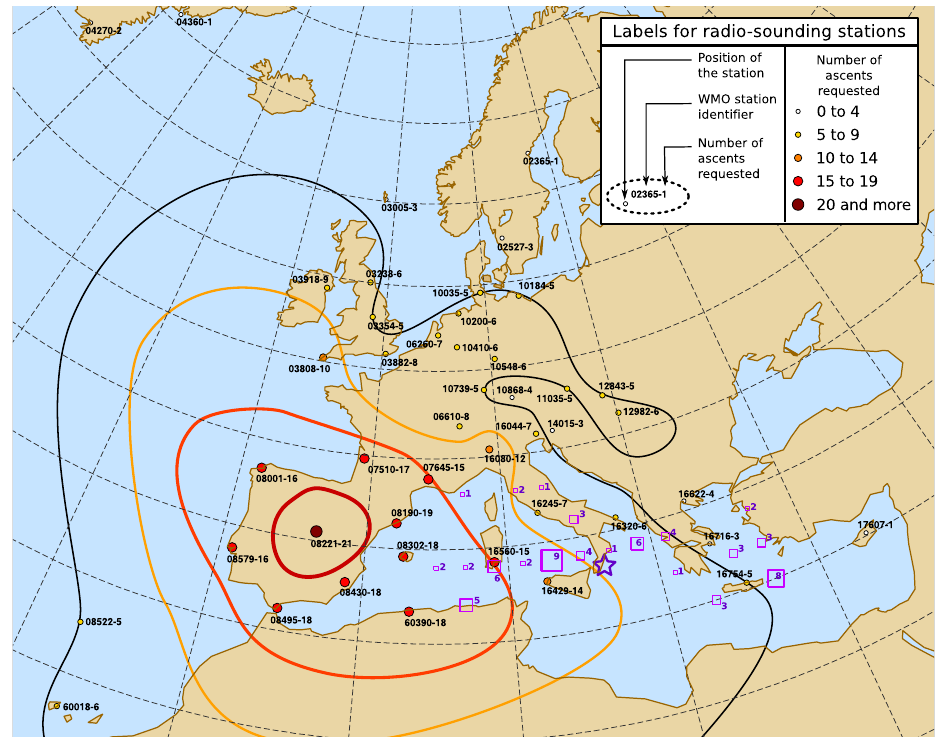
Fig. 3. Distribution of the average sensitivity to the forecast of high impact weather in the Mediterranean, indirectly measured through the frequency of extra-soundings request during the DTS-MEDEX-2009 campaign. The isolines are drawn for values of frequency of 5, 10, 15 and 20 requests. The size of the pink squares, in the centre of 2 ◦ × 2 ◦ lat-long areas, indicates the frequency of the location in these areas of the centre of the area of interest (or verifying area, VA) defined for the selected cases. The violet star is the “gravity centre” of the locations of the centres of all the areas of interest. All values in this figure are referred to the sub-period 31 October 2009 to 13 December 2009, in which all the targetable stations (small circles) were